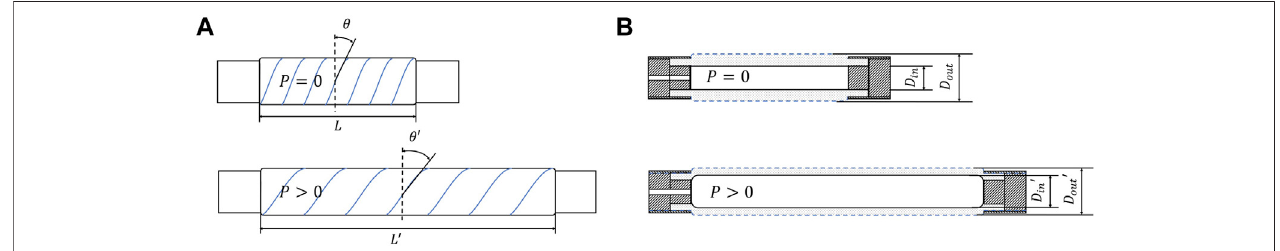
FIGURE1|(A) AviewofanextensileFAMin:arestingstate(top),apressurizedstate(bottom). (B) Alongitudinalcross-sectionviewofanextensileFAMin:aresting state (top), a pressurized state without external forces